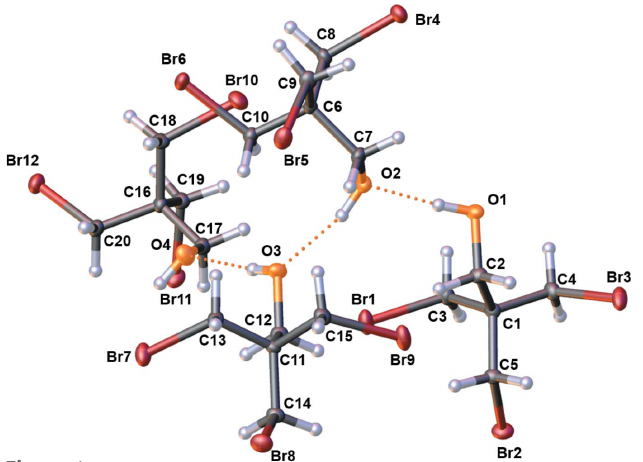
Figure 1 The molecular structure of bromomethylalcohol 1 with displacement ellipsoids drawn at the 50% probability